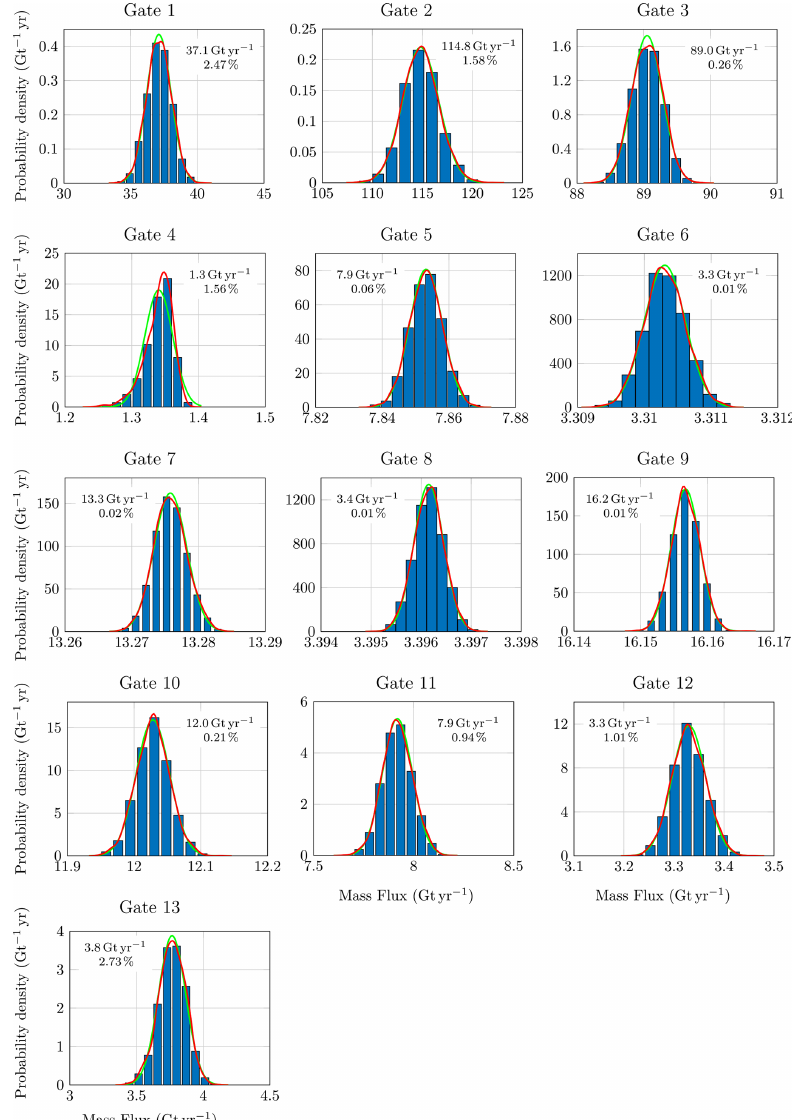
Figure 9. Normalized histograms for the mass flux across the fluxgates depicted in Fig. 5. The mean (in Gtyr − 1 ) and the coefficient of variation (in percent) are provided for each gate. The kernel density estimate of the probability density function is shown in red, and its Gaussian approximation with corresponding mean and coefficient of variation is shown in green. Results are obtained for a parameter range of